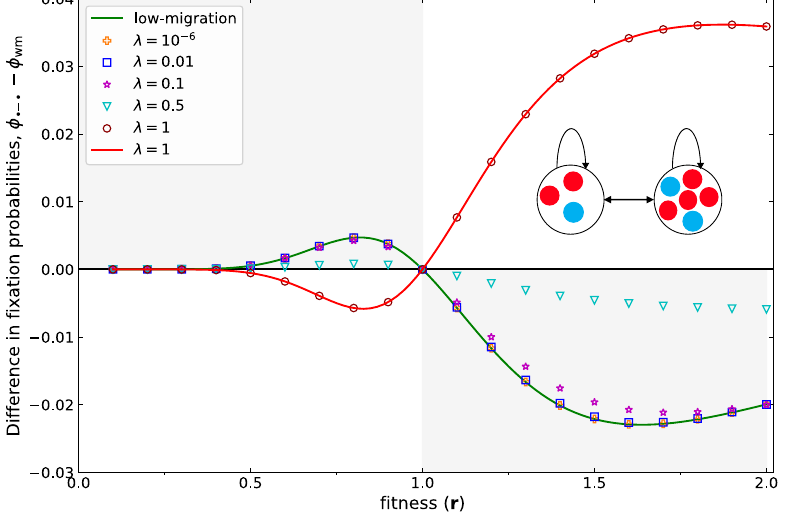
Figure 2. The difference between the fixation probability of a two-patch meta-population and a well-mixed population of the same size, N = 10 . The two patch sizes are N 1 = 3 and N 2 = 7 . Lines show analytical results for low migration probabilities (Eq. 4) and migration probability (cid:31) = 1 (Eq. 19) as a function of fitness. Symbols show numerical results based on a transition matrix approach 39 . The numerical result and analytical result for low migration probability and high migration match perfectly. In the low migration regime the two-patch meta- population is a suppressor of selection, indicated by the fact that the symbols are never in the area with a white background. However, in the high migration regime ( (cid:31) = 1 ), where simulations and analytical results again match, the two-patch meta-population is an amplifier of selection. The fixation probability for (cid:31) = 1 is obtained analytically using the Martingale approach discussed by Monk 41